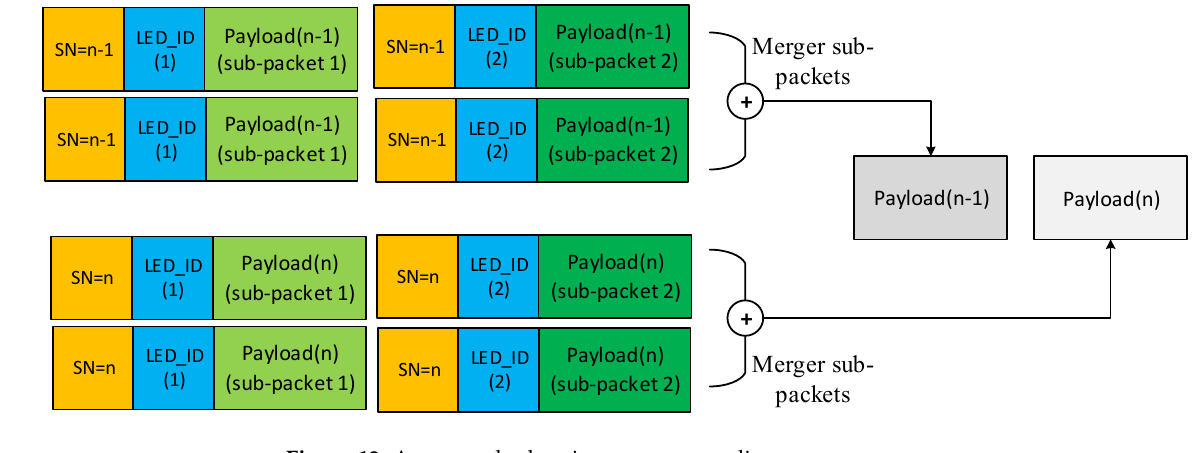
Figure 13. An example showing an oversampling case.